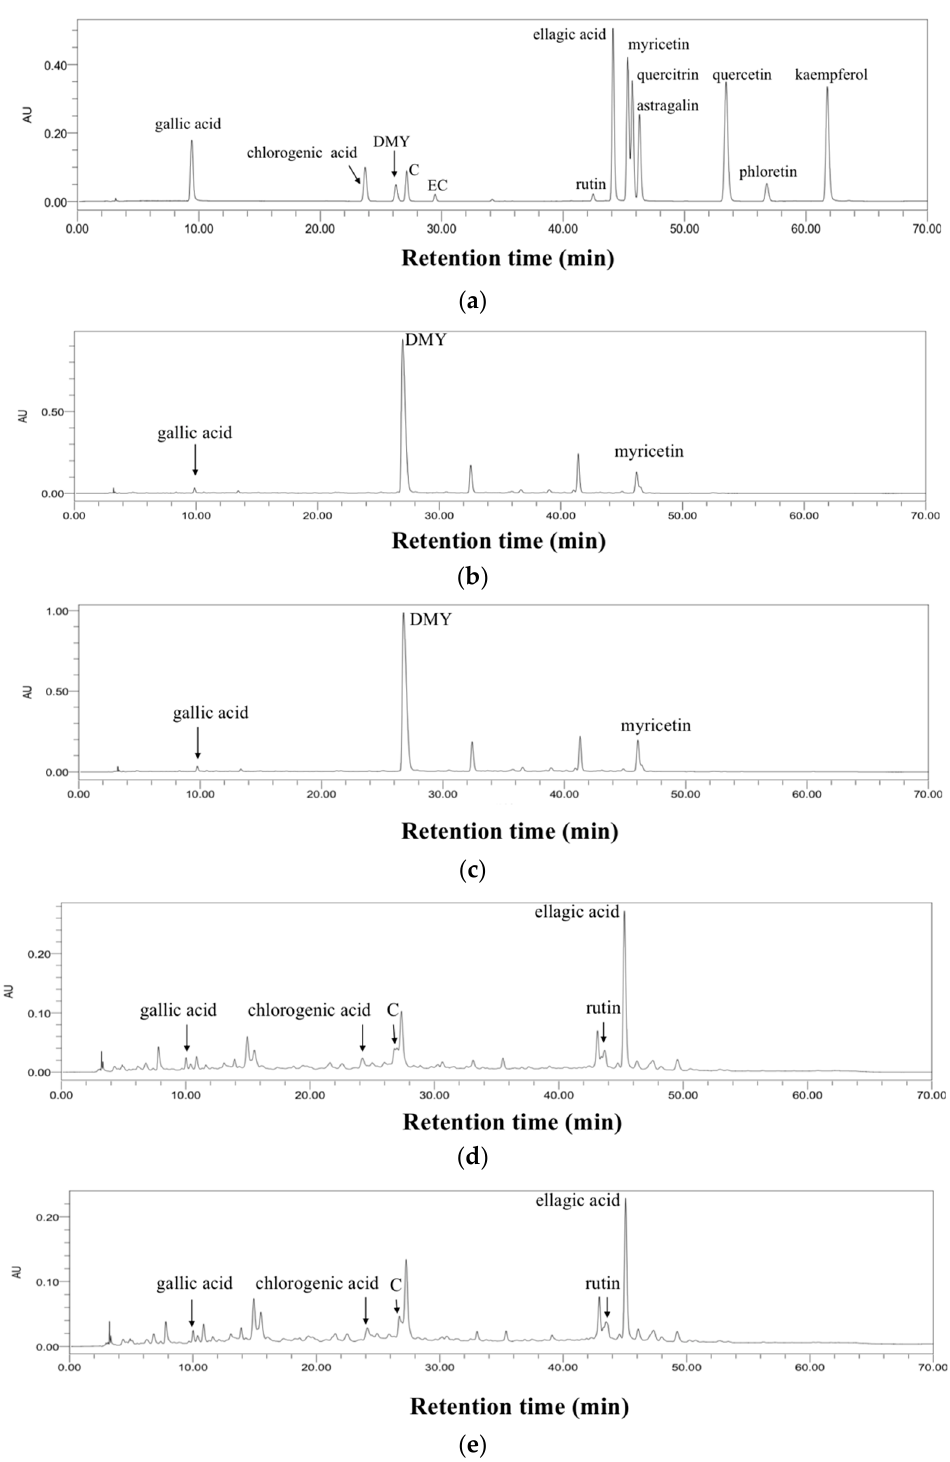
Figure 5. The representative chromatograms of standards and kombucha beverages at 254 nm. ( a ) standards, ( b ) kombucha from vine tea without tea residues, ( c ) kombucha from vine tea with tea residues, ( d ) kombucha from sweet tea without tea residues, and ( e ) kombucha from sweet tea with tea residues. DMY, dihydromyricetin; C, catechin; EC,